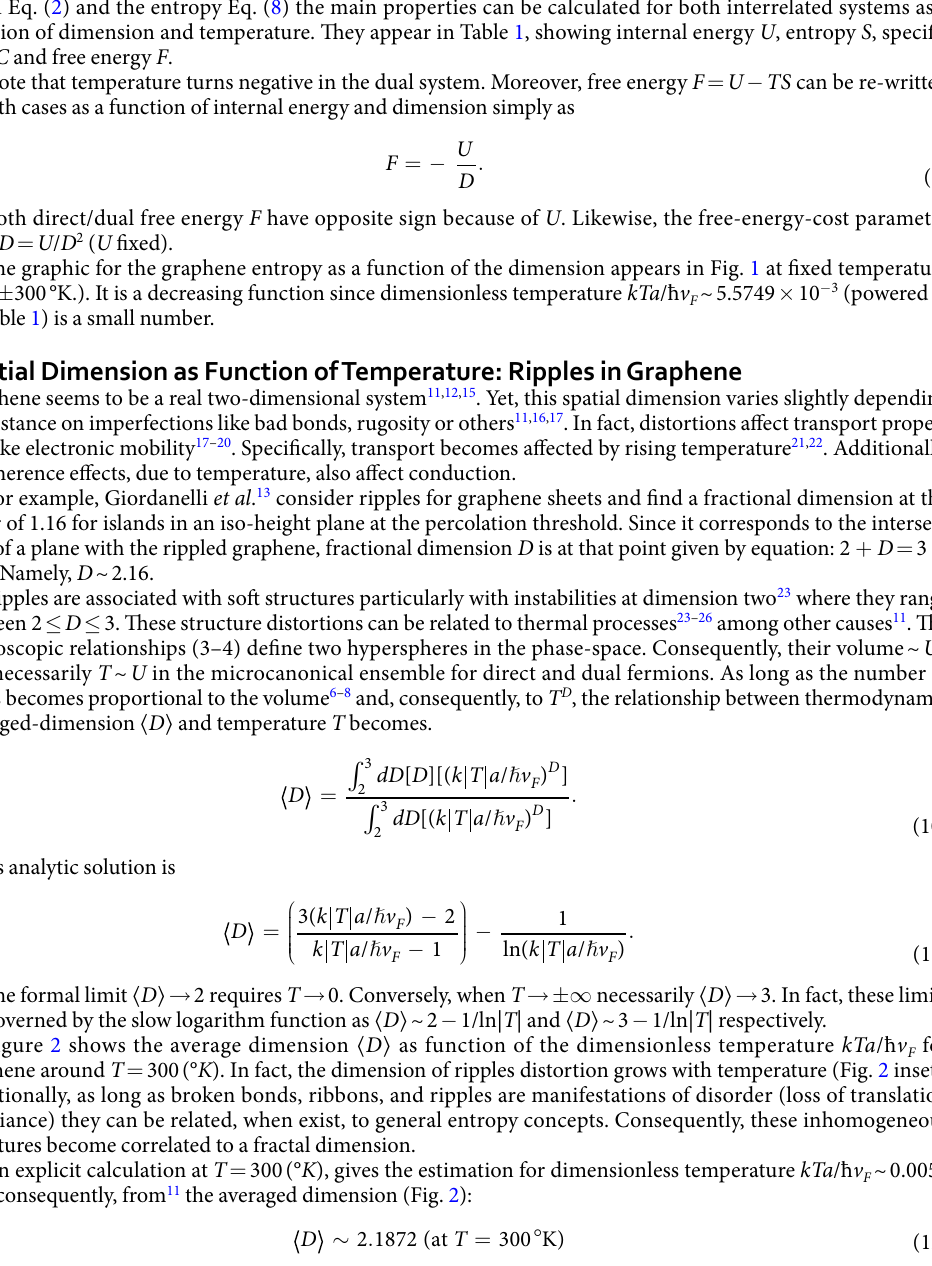
Thermodynamic Relationships for Direct/Dual Dirac Fermions and Dimension Dependences